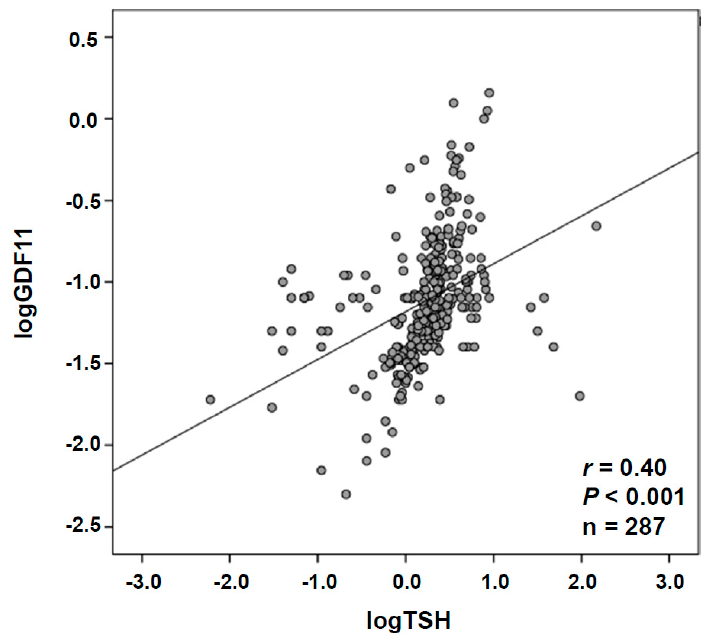
Figure 1. Association of growth differentiation factor 11 (GDF11) concentrations with thyroid-stimulating hormone (TSH) levels. Scatter diagram showing the correlation between the circulating concentrations of GDF11 and TSH. Pearson’s correlation coefficient and p value are indicated. The line of adjustment is shown. Table 1. Demographic, biochemical, and metabolic characteristics of the individuals included in the overall study.